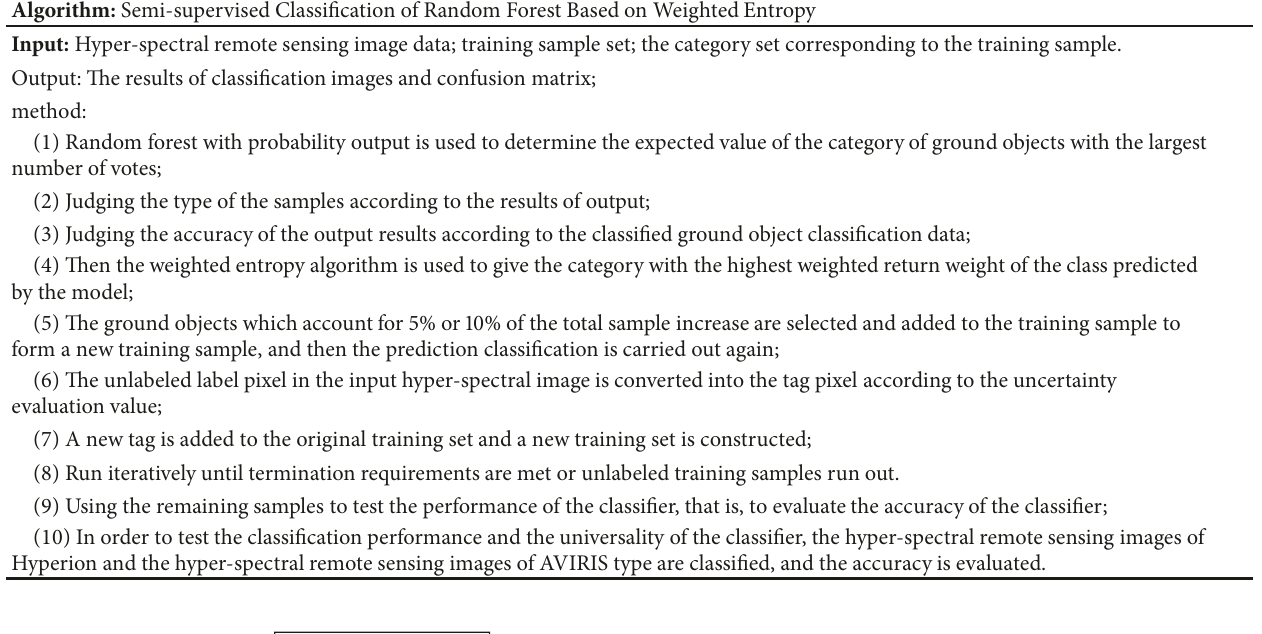
Table 2: The process of semisupervised classification of random forest based on weighted entropy algorithm. A lgorithm : Semi-supervised Classification of Random Forest Based on Weighted Entropy